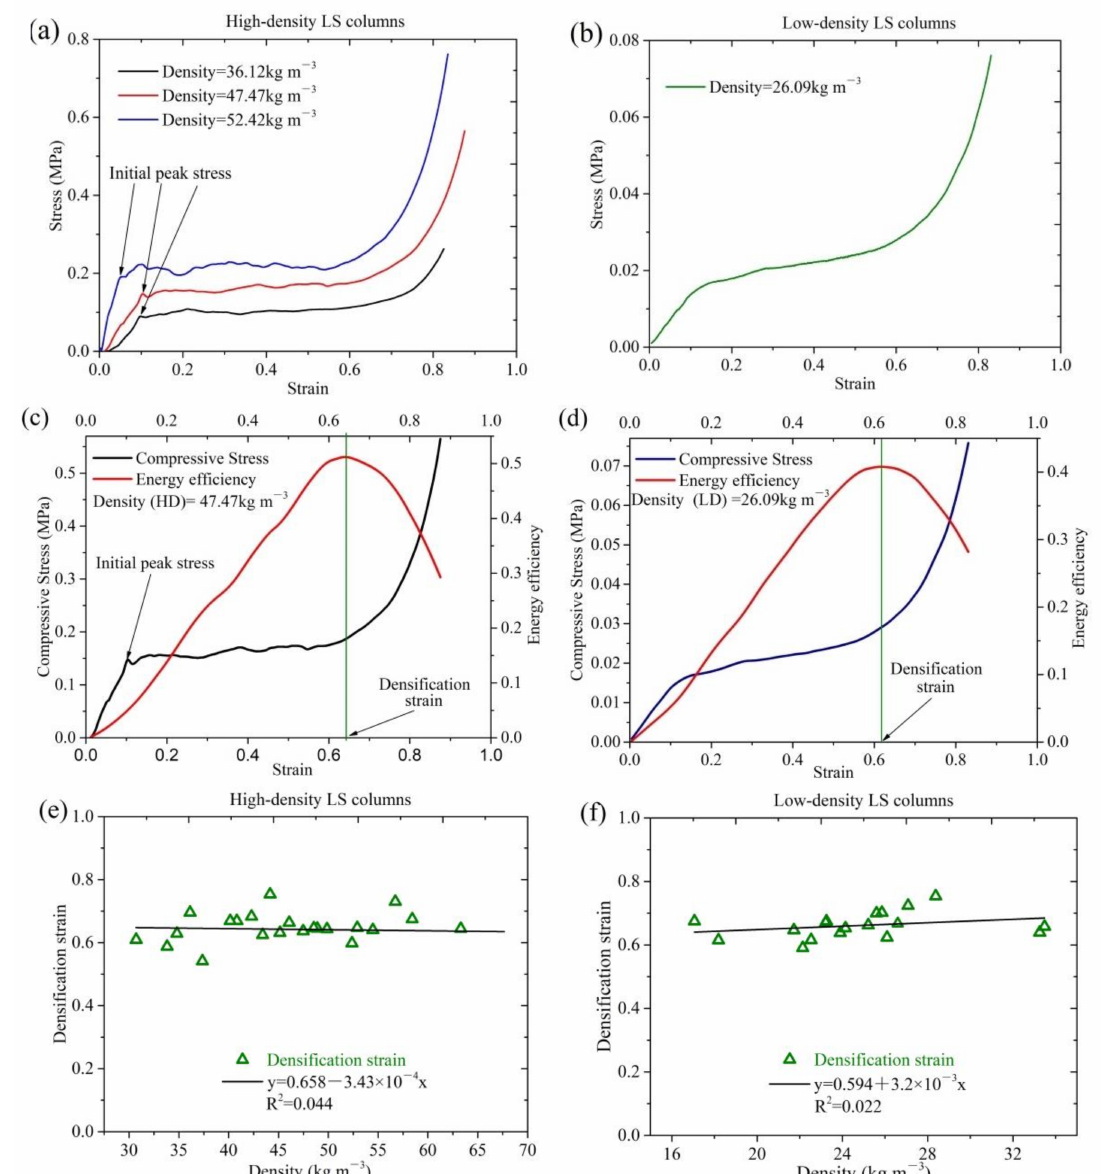
Figure 3. The mechanical properties of the two types of LS column: ( a ) the stress–strain curves of high-density LS columns, ( b ) the stress–strain curve of low-density LS columns; ( c , d ) illustration of the densification strain method; ( e ) densification strain of high-density LS columns; and ( f ) densification strain of low-density LS